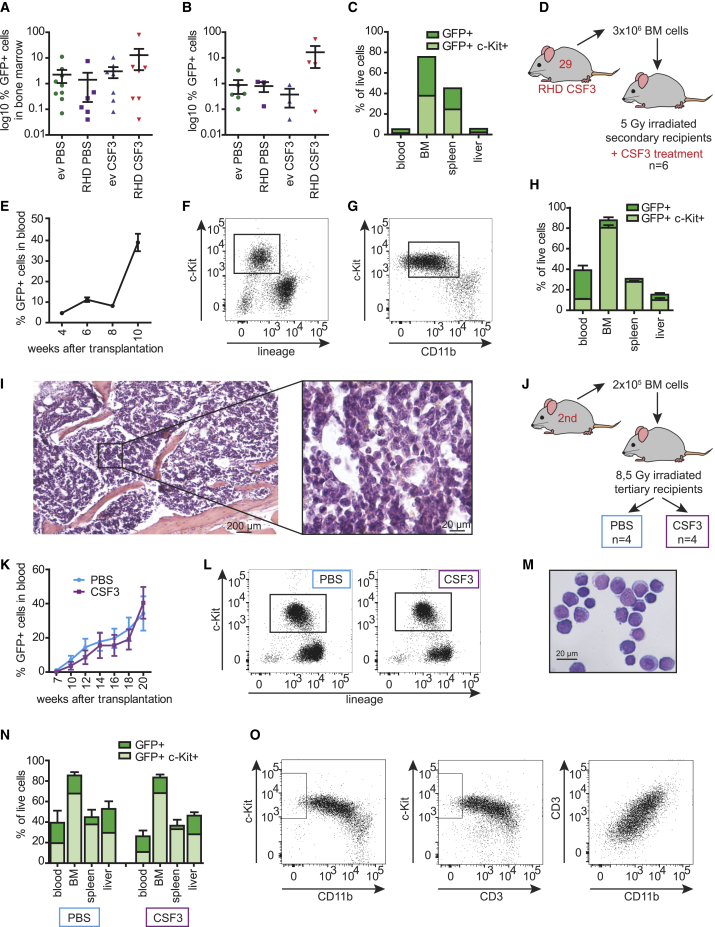
Spleen Infiltration and CSF3-Independent Leukemogenic Properties of d715-RHD Cells(A and B) Distribution of GFP-expressing cells in (A) BM and (B) spleen in primary recipients, showing enhanced spleen infiltration in CSF3-treated d175-RHD mice.(C). Relative distributions of total GFP+ and GFP+c-Kit+ cells in various organs of mouse 29.(D) Secondary transplant setup; cells from mouse 29 were transplanted into 6 recipients.(E–G) Expansion of GFP+ cells in PB of 6 secondary recipients (E, biological replicates), with (F) the c-Kit+ immunophenotype and (G) intermediate CD11b expression on c-Kit+ cells.(H) Organ distribution of GFP+ and GFP+c-Kit+ cells.(I) H&E staining of the spine, showing a hypercellular BM with more than 90% myeloblast infiltration. The scale bars indicate 200 and 20 μm, respectively.(J) Tertiary transplantation setup.(K) Equal expansion of GFP+ cells in PB of CSF3-treated (n = 4) or PBS-treated (n = 4) mice (biological replicates).(L) The c-Kit+ phenotype of PB GFP+ cells in CSF3- and PBS-treated mice.(M) Blast morphology of FACS-purified c-Kit+ PB cells.(N) Organ distribution of GFP+ and GFP+c-Kit+ cells in PBS- or CSF3-treated mice (n = 4 per group).(O) FACS analysis showing an immature (c-Kit+) mixed myeloid (CD11b+) and T cell (CD3+) immunophenotype of AML blasts; the boxes indicate c-Kit+CD11b−CD3−.Error bars represent SEM. See also Figure S2.